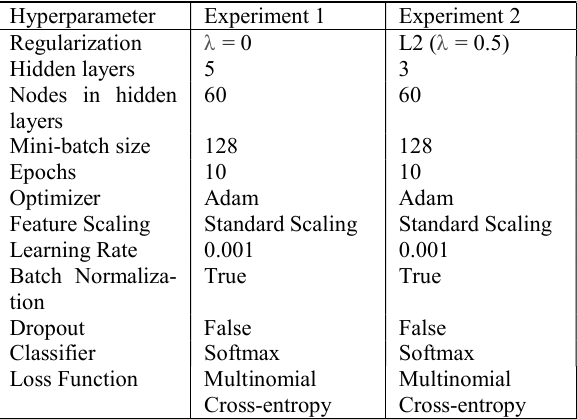
Table 4. Hyperparameters of the Neural Network